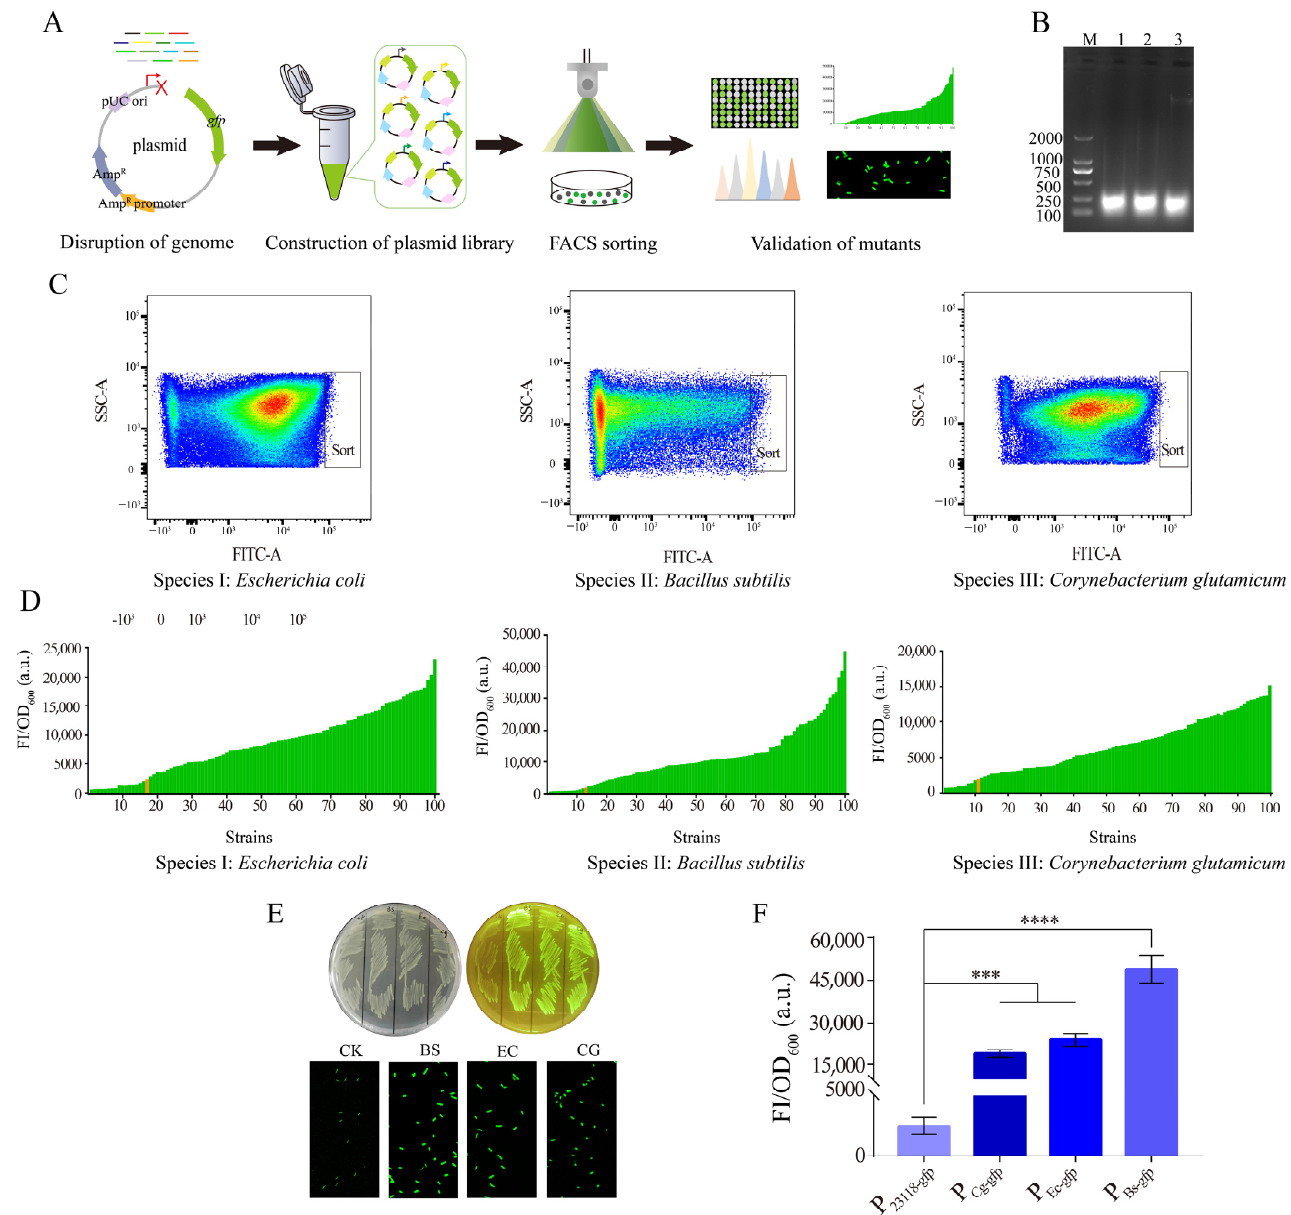
Figure 1. Design and construction of a novel approach for screening strong constitutive promoters. ( A ) Schematic diagram of screening process of the strong constitutive promoters. ( B ) Gel of randomly interrupted genomes of E. coli MG1655, B. subtilis 168, and C. glutamicum ATCC13032. M: Marker DL2000. Lane 1: Random interruption of the E. coli MG1655 genome. Lane 2: Random interruption of the B. subtilis 168 genome. Lane 3: Random interruption of the C. glutamicum ATCC13032 genome. ( C ) FACS sorting of the strong promoters from the three different sources. ( D ) Rescreening of the mutants with higher fluorescence intensities in 96-deep-well plates. The left panel shows the constitu- tive promoters screened from E. coli MG1655, the middle panel exhibits the constitutive promoters screened from B. subtilis 168, and the right panel represents the constitutive promoters screened from C. glutamicum ATCC13032. The orange band represents the control strain. ( E ) Visual comparison of promoter intensities from three different sources under blue light (upper panel). Fluorescence microscopy images of strains carrying three sources of promoters (lower panel). ( F ) Comparison of fluorescence intensity of the strongest promoters screened from the three sources. For ( F ), error bars indicate standard deviations. One-way analysis of variance (ANOVA) was used to examine the mean differences between the data groups. **** p < 0.001, *** p <